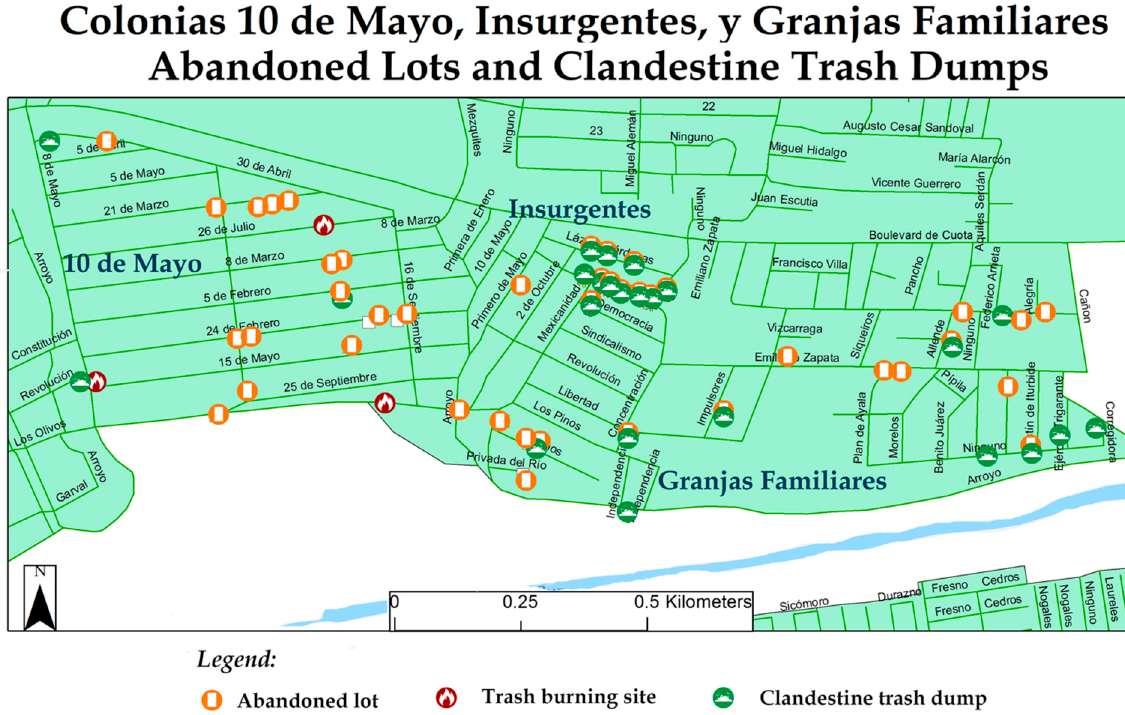
Figure 6. RECIMEC region abandoned lots and trash dumps.